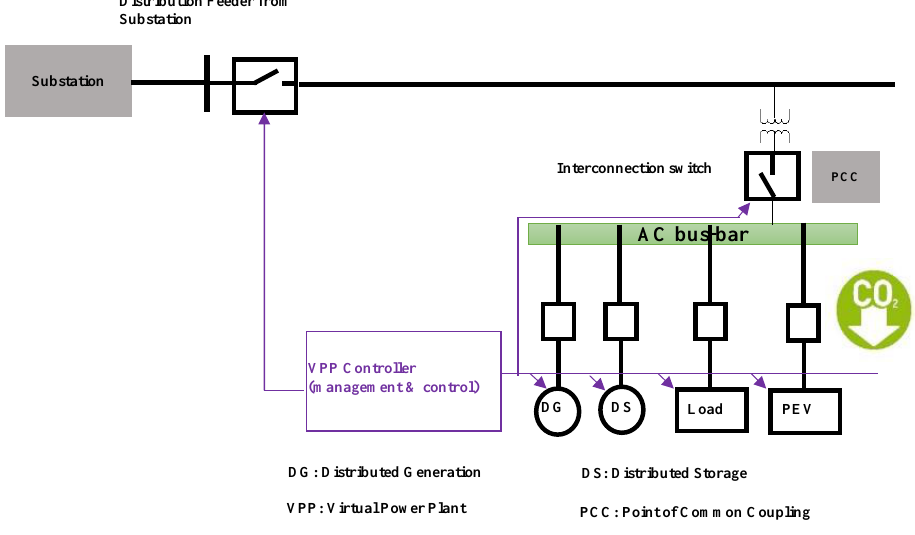
Figure 2. Integration of DERs and loads within the Triangulum